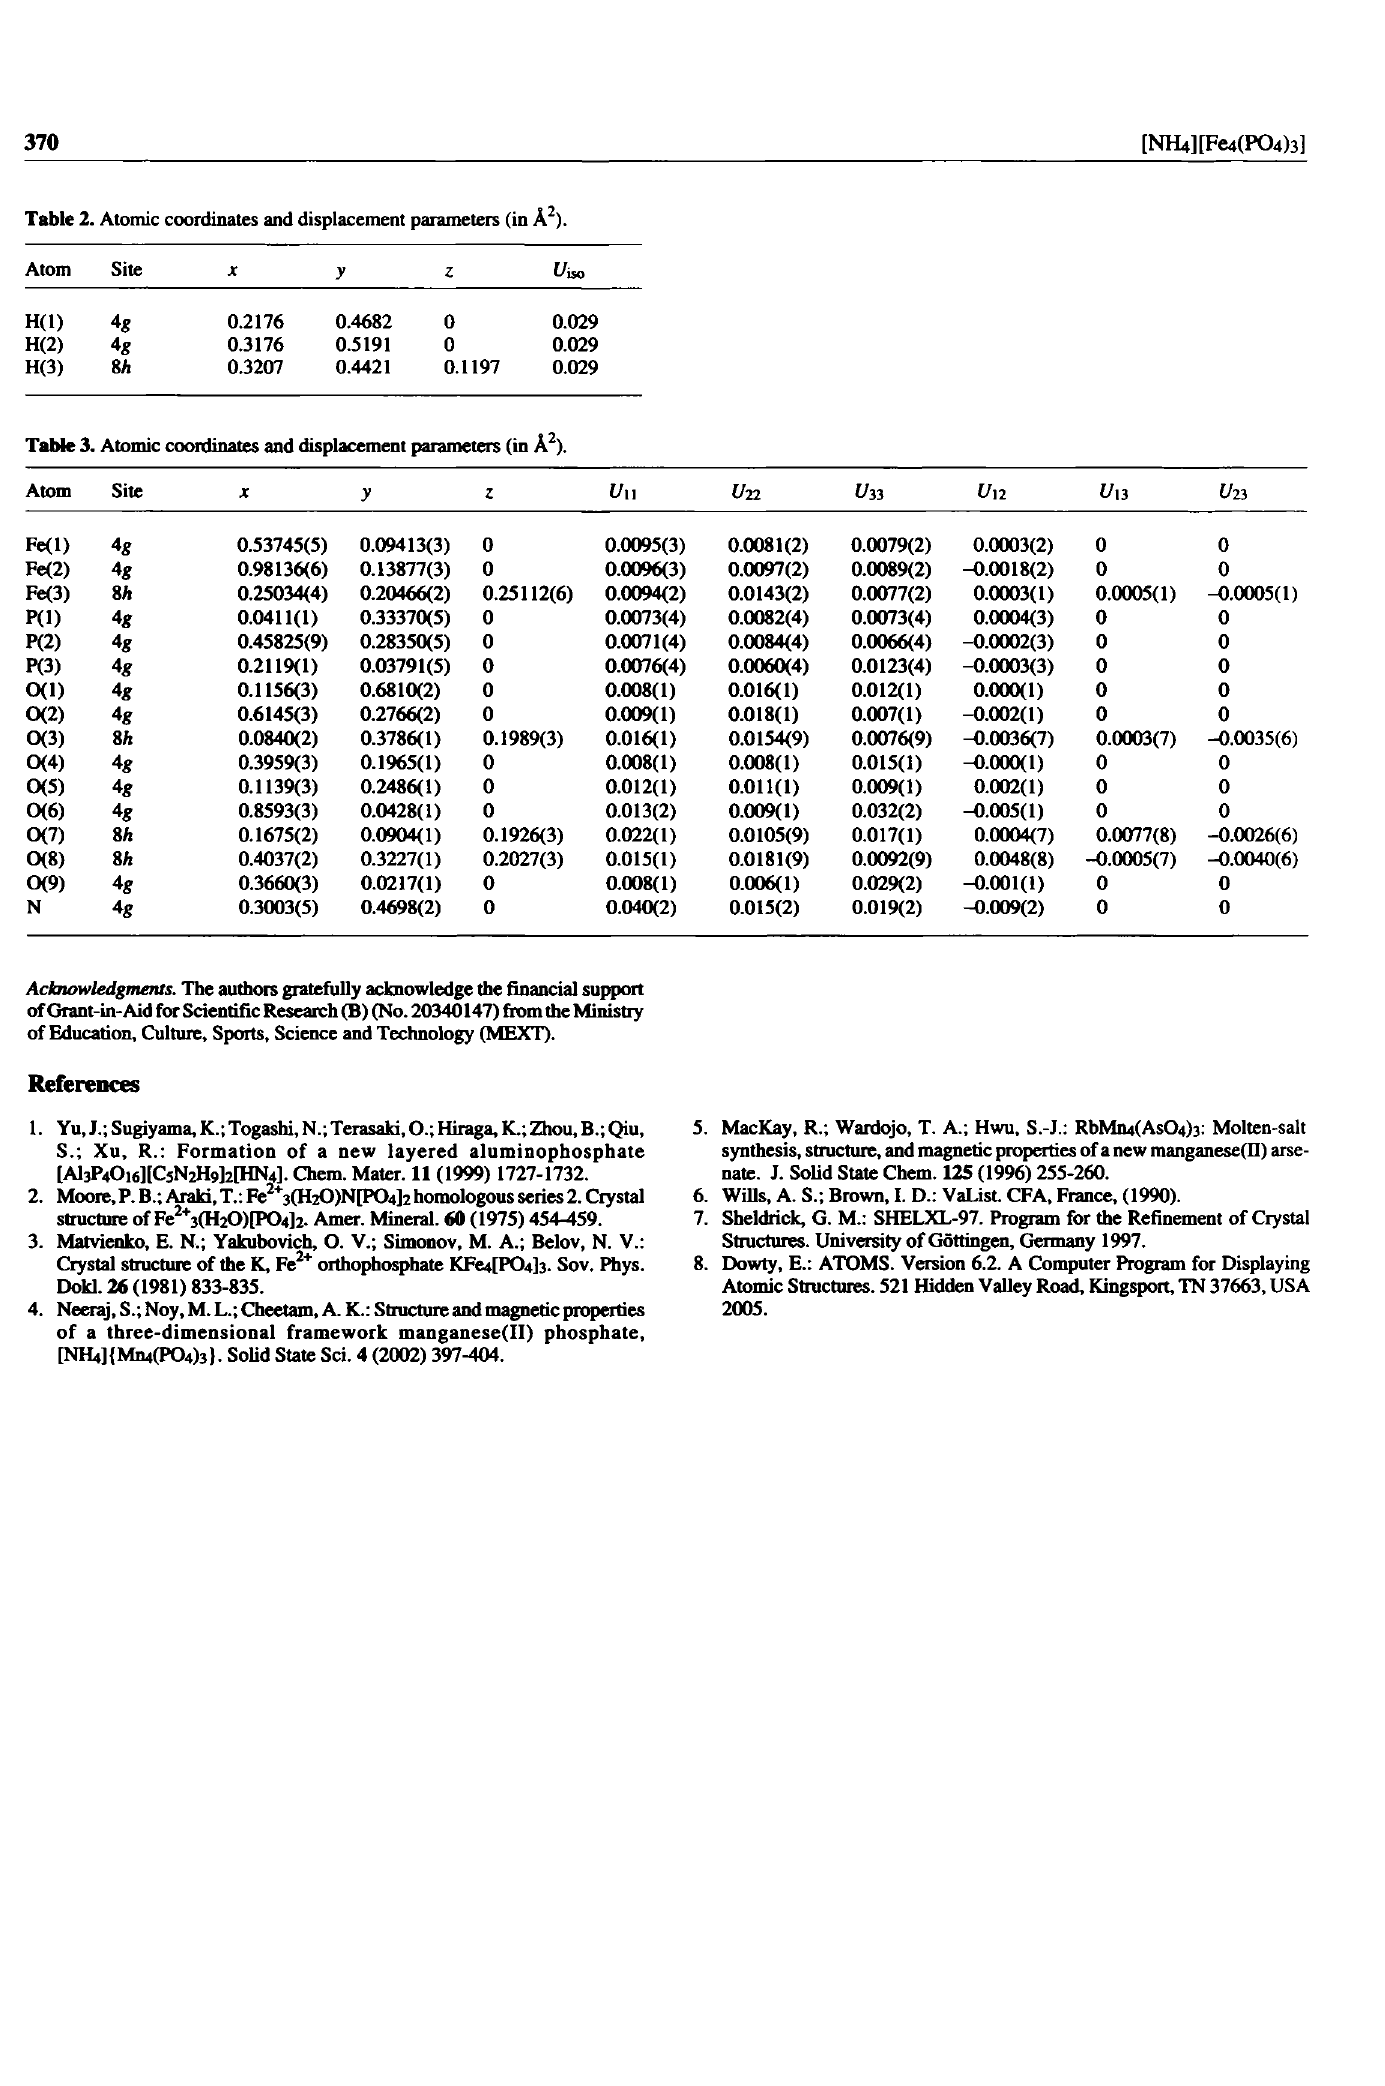
Table 3. Atomic coordinates and displacement parameters (in Â 2